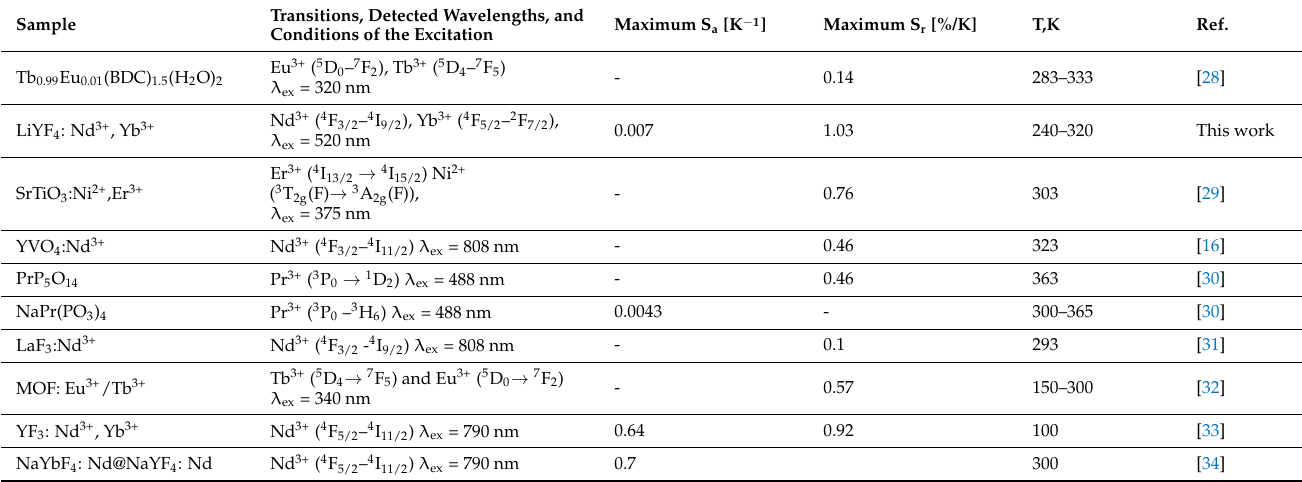
Table 1. The performances of rare-earth doped optical thermometers.